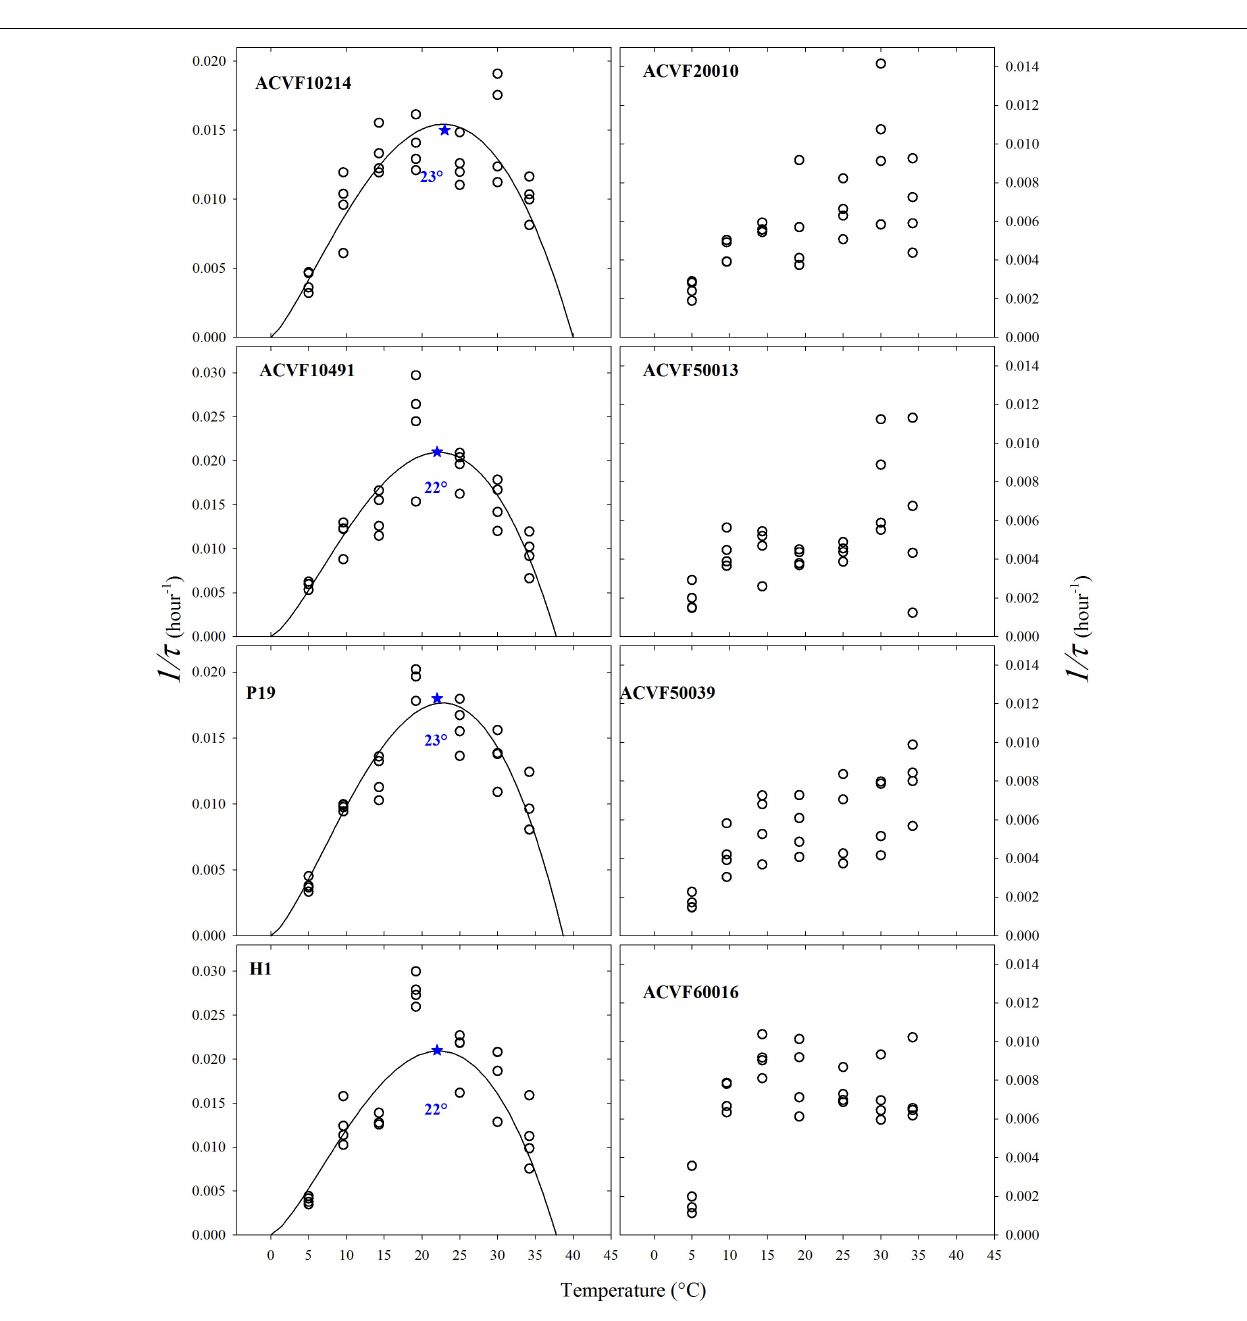
Finally, the response of accessions ACVF10491 and ACVF60016 adjusted on the data of accessions ACVF10214 and